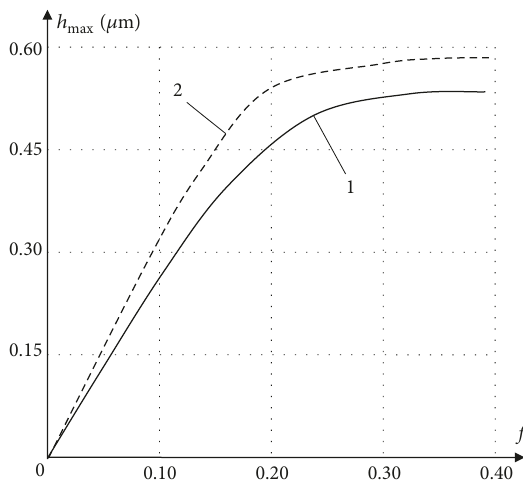
Figure 8: Dependence of maximum wear for friction path corre- sponding to ten work hours of the